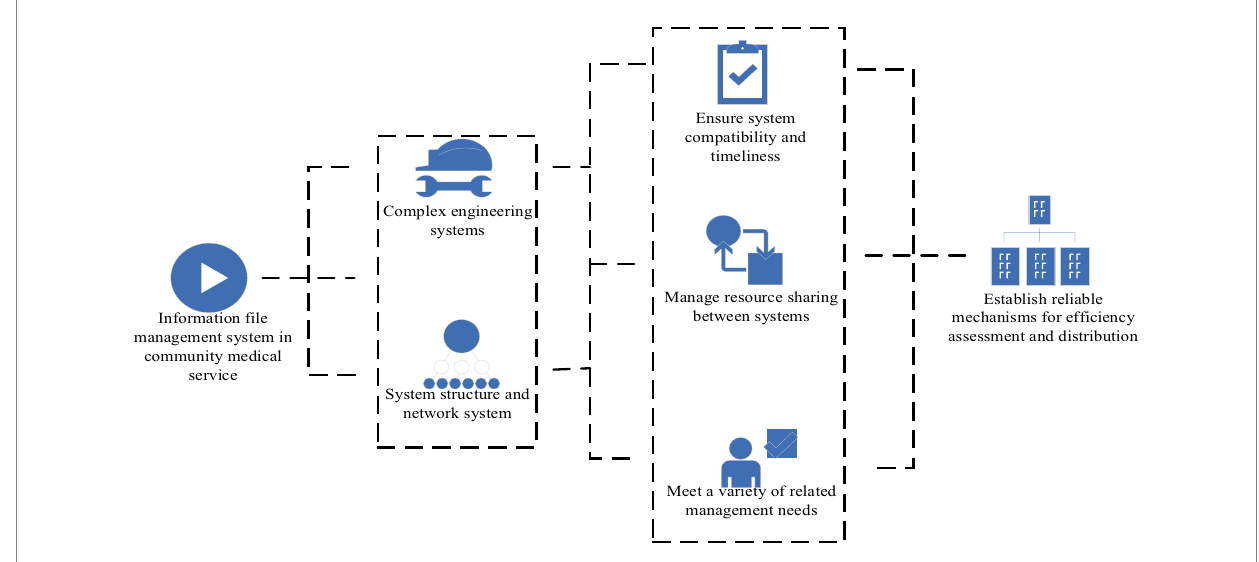
FIGURE 4 Development requirements of the medical information archives management system in community.